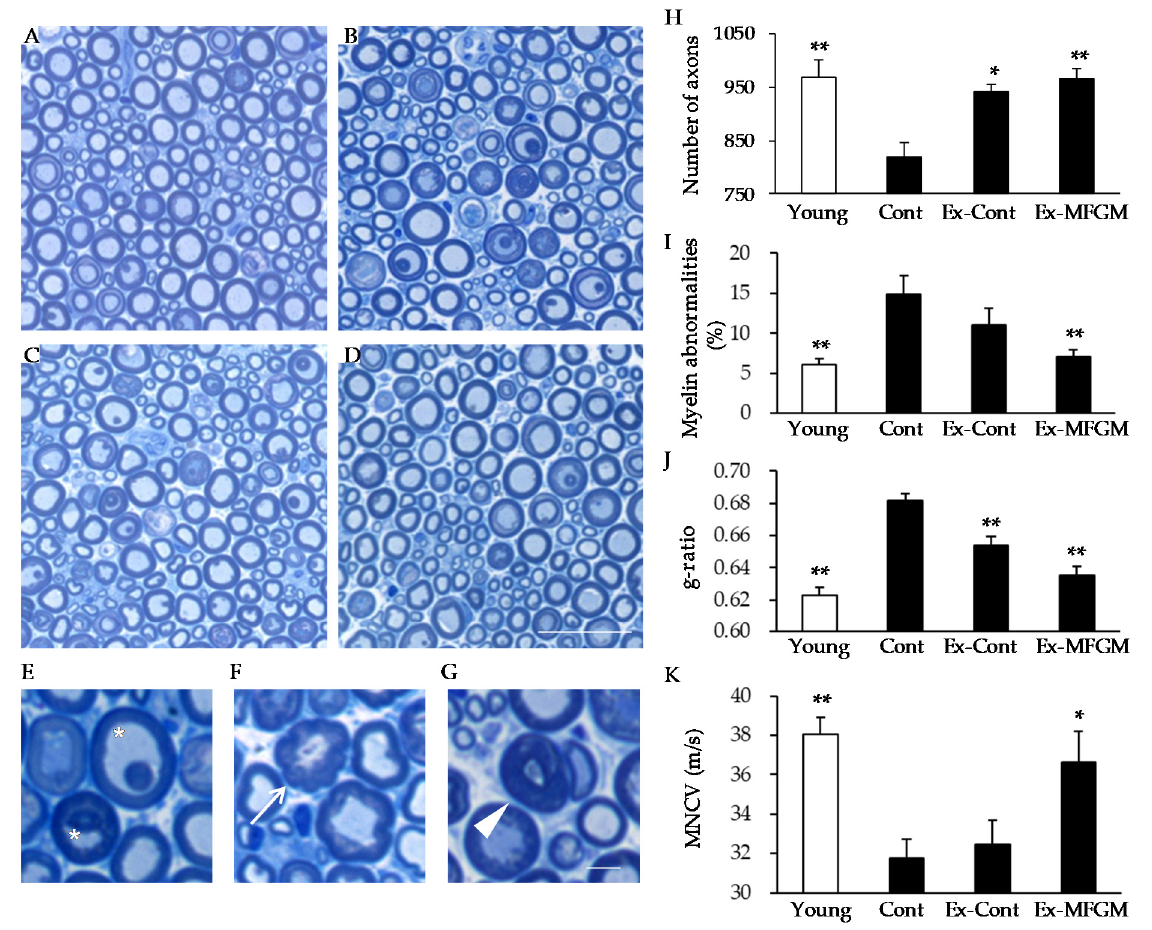
Figure 5. Effect of MFGM intake with exercise from an old age on nerve structure and function. ( A – G ) Semi-thin cross- sections of the peroneal nerve stained with toluidine blue. Low-magnification images of nerves at 10 months old (Young; ( A )) and 24 months old (Cont, ( B ); Ex-Cont, ( C ); Ex-MFGM, ( D )) are shown. High-magnification images of nerves are shown in ( E – G ). Age-related alterations included myelin inclusion (asterisk) ( E ), myelin outfoldings (arrow) ( F ), and tomacular structures (arrowhead) ( G ). ( H ) Number of axons present in the peroneal nerve. ( I ) The percentages of myelin abnormalities comprising myelin inclusions, myelin outfoldings, and tomacular structures were determined. ( J ) The ratio of nerve fiber diameter divided by axon diameter (g-ratio) was calculated. ( K ) The motor nerve conduction velocity was analyzed. Values are presented as the mean ± SE ( n = 5–9 in each group). * p < 0.05, ** p < 0.01 vs. Young group. Scale bars: 30 µm ( A – D ) and 10 µm ( E – G ). MFGM, milk fat globule membrane; MNCV, motor nerve conduction velocity; Young, young group; Cont, control diet group; Ex-Cont, control diet with exercise group; Ex-MFGM, milk fat globule membrane diet with exercise group.